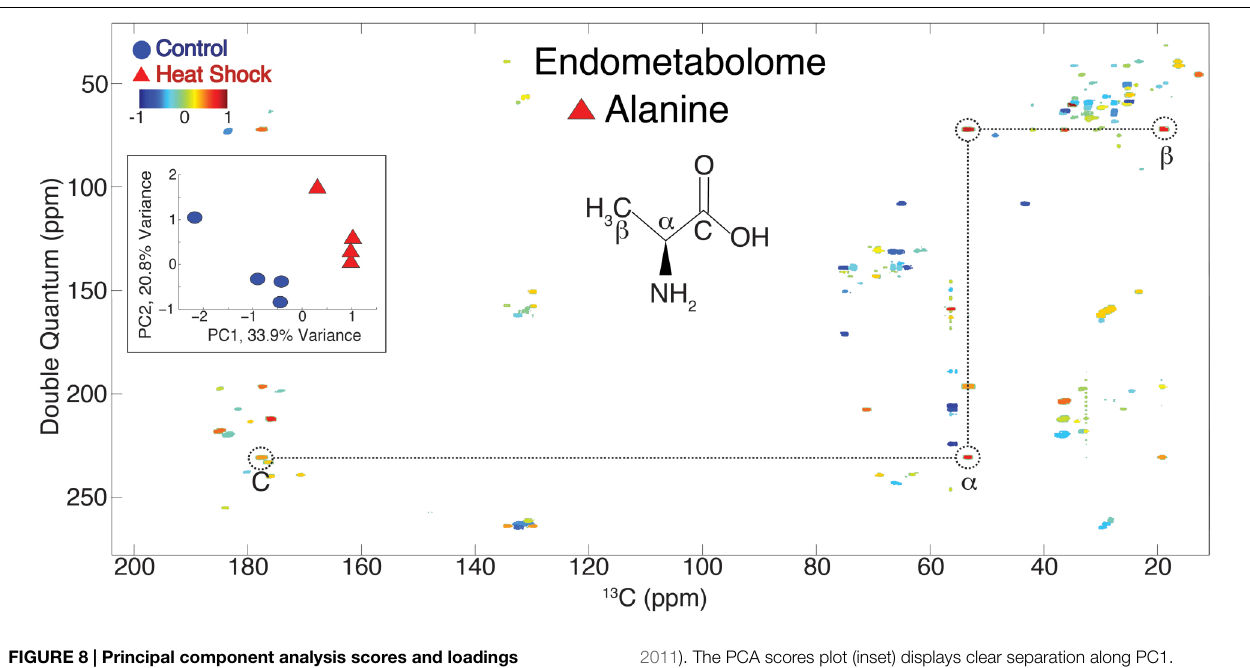
FIGURE 8 | Principal component analysis scores and loadings plot of control (blue circle) and heat shock (red triangle) for all the INADEQUATE 2D NMR data from the C. elegans endometabolome. This 2D NMR PCA was developed for TOCSY spectra but can be applied to any 2D NMR data (Robinette et al.,